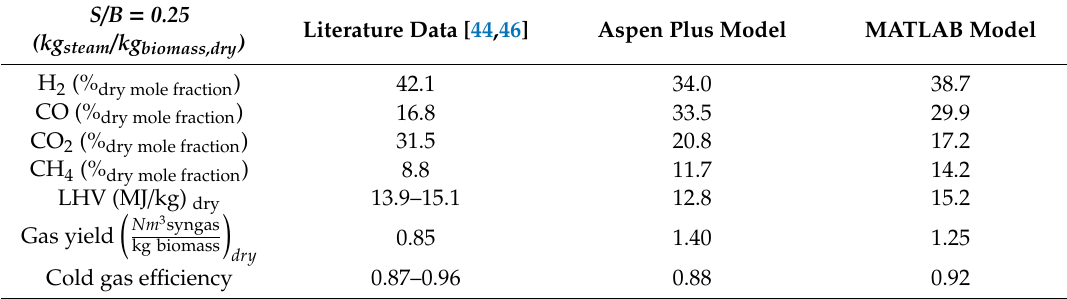
Table 3. Comparison of syngas composition and characteristics (S / B = 0.25).